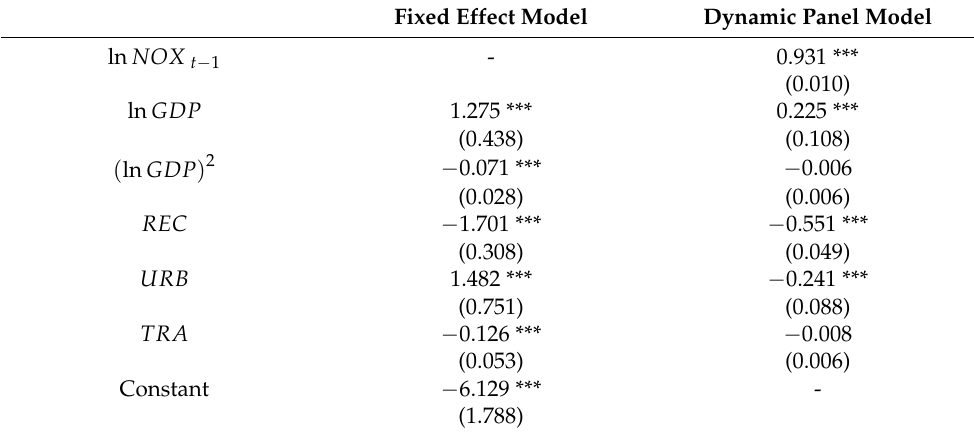
Table 4. Estimation Results for Nitrogen Oxide Emissions (NO X ).